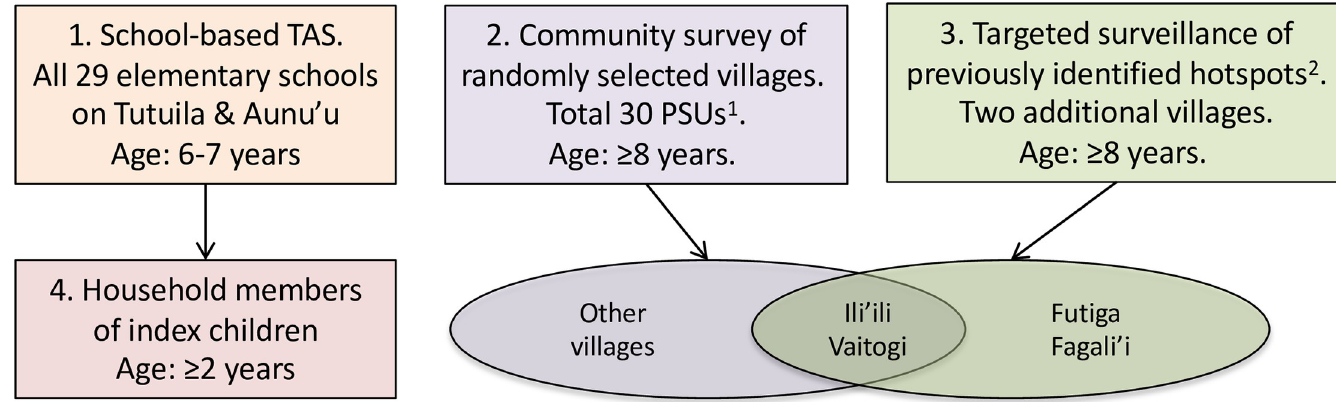
Fig 1. Summary of survey components, American Samoa 2016: 1) School-based TAS, 2) Community-based survey of randomly selected villages, 3) Targeted surveillance of previously identified hotspots, and 4) Household members of index children. 1 PSU = Primary sampling unit, with maximum population of 2000. Most PSUs consisted of one village, but some of the larger villages were split into PSUs of < 2000 people before random selection. The very small contiguous villages of Satala, Anua, and Atu’u were combined to form one PSU. 2 Two previously identified hotspots were Fagali’i village and the contiguous villages of Ili’ili/Vaitogi/Futiga. Ili’ili and Vaitogi villages were randomly selected for the community survey, and the other two specifically